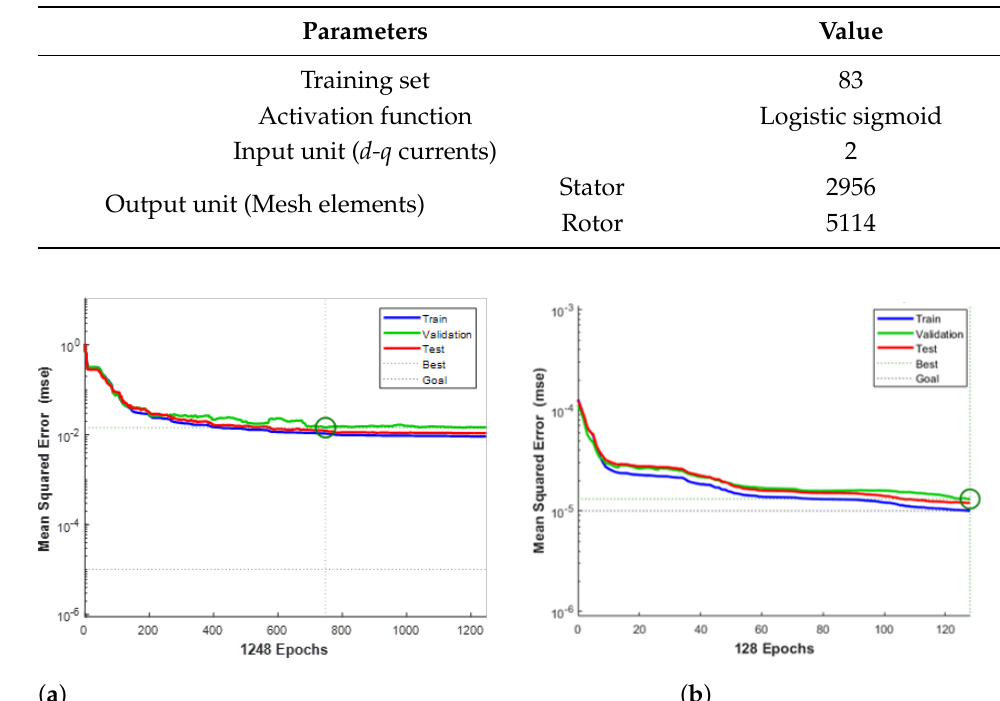
Table 3. Learning Parameters.